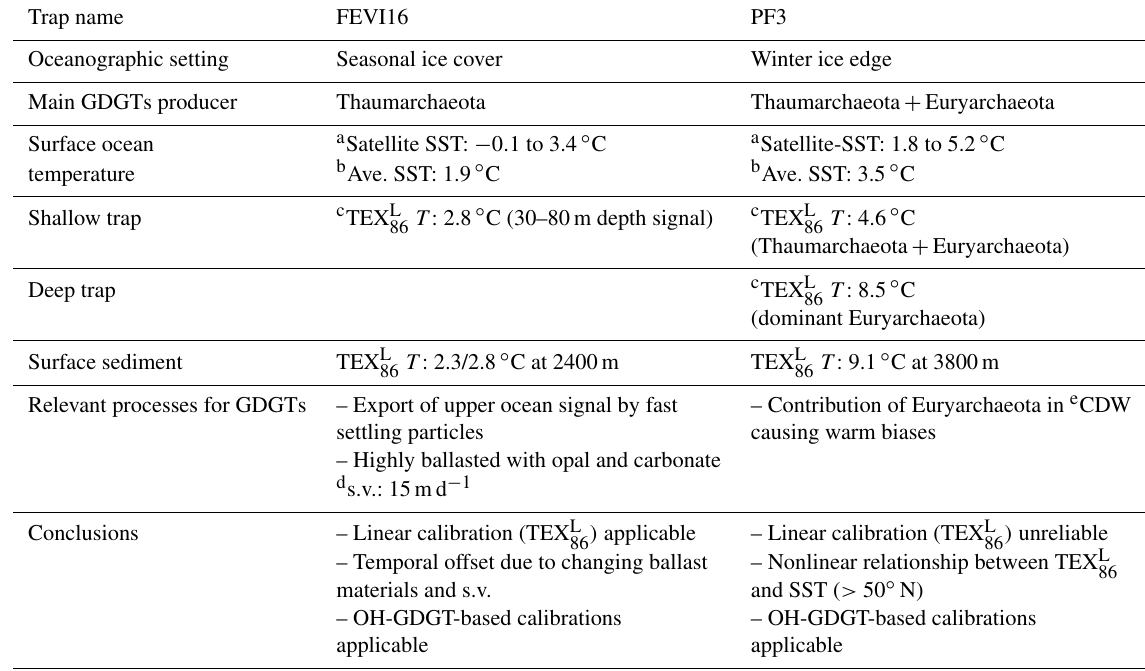
thermometry in FEVI16 and PF3 86